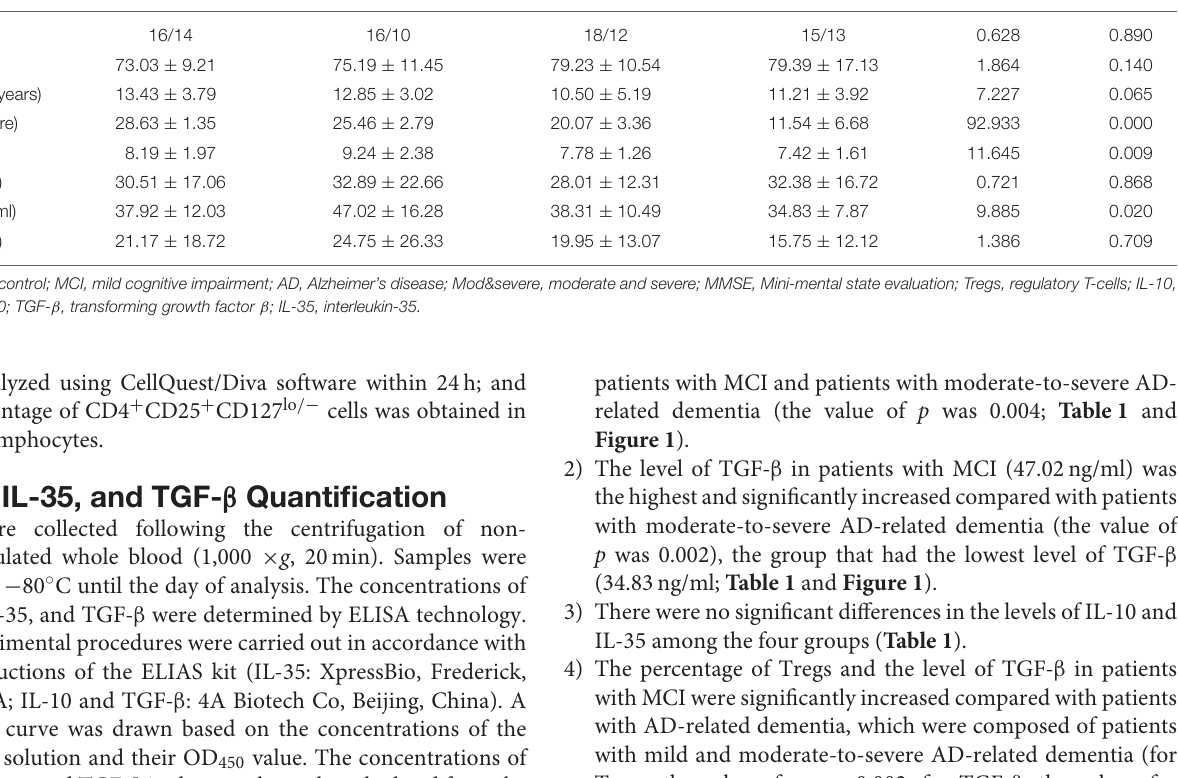
TABLE 1 | Patients’ clinical data, percentage of Tregs, and related cytokine levels of four groups.